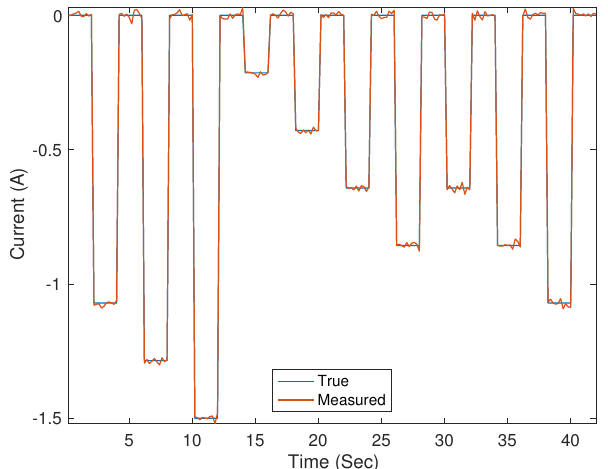
Figure 4. Current measurement error. True vs. measured current that was simulated by assuming a current measurement error standard deviation of σ i = 10 mA.